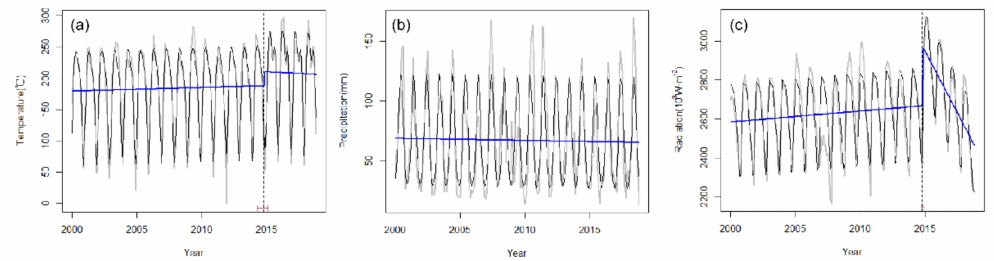
Figure 7. Spatial distributions of the maximum PCC between the NDVI, and ( a ) temperature, ( b ) precipitation, and ( c ) radiation by considering the time effect. ( d – f ) Corresponding times with the maximum PCC. ( g ) Spatial distribution of the main climate-driven factors with respect to vegetation growth. ( h ) Spatial pattern of the determination coefficient (R 2 ) of the multiple linear regression model of the NDVI against climatic factors by considering the effects of both the time lag and time accumulation.